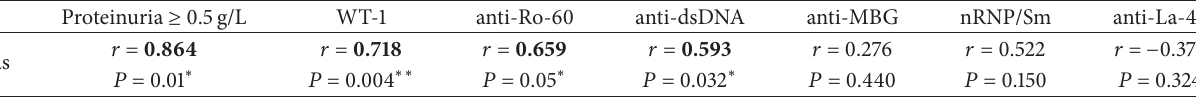
Figure 5: The expression of mRNA Fas receptor in renal tissue of LN patients and HS by FISH. The upper panel (a), (b), and (c) shows the HS tissue, and the lower panel (d), (e), and (f) shows a representative LN. (a) and (d) Expression of the mRNA Fas receptor (red). (b) and (e) Staining in blue by DAPI. (c) and (f) show the overlapping (pink). Table 3: Correlation between sFas levels and markers of disease in LN patients.